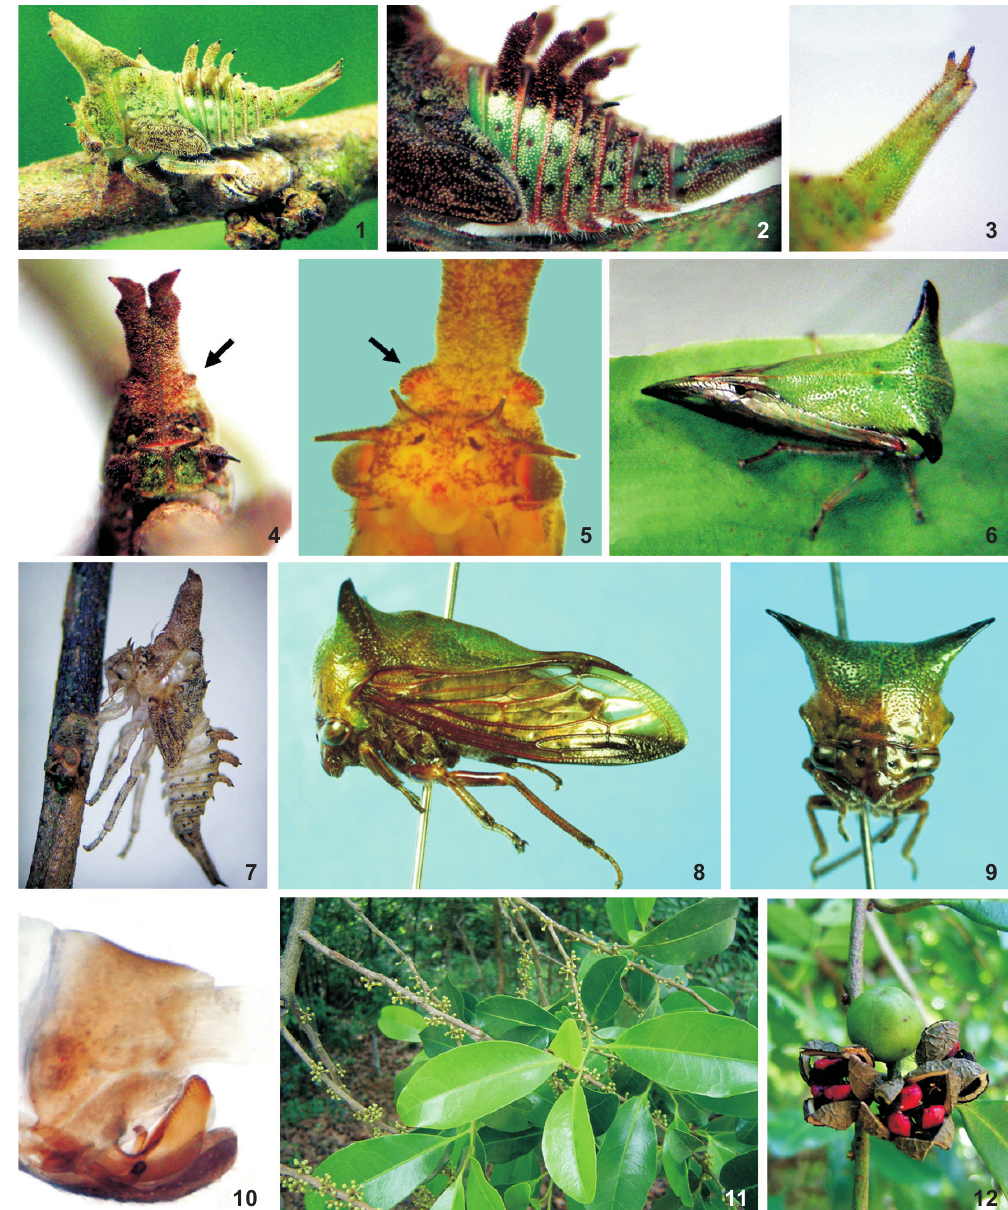
Figures 1-12. Alcmeone robustus . (1-10) Nymph and adults: (1) 5 th instar nymph, lateral view; (2) detail of abdomen, showing dorsal scoli and pad-like expansions at latero-posterior margins of segments; (3) pygopher (segment IX); (4) frontal view (arrow indicating supra-humeral horn bud); (5) detail of head (arrow indicating supra-humeral horn bud); (6) adult male; (7) exuvia; (8-9) adult female; (10) male genitalia; (11-12) Pera sp., Euphorbiaceae, host